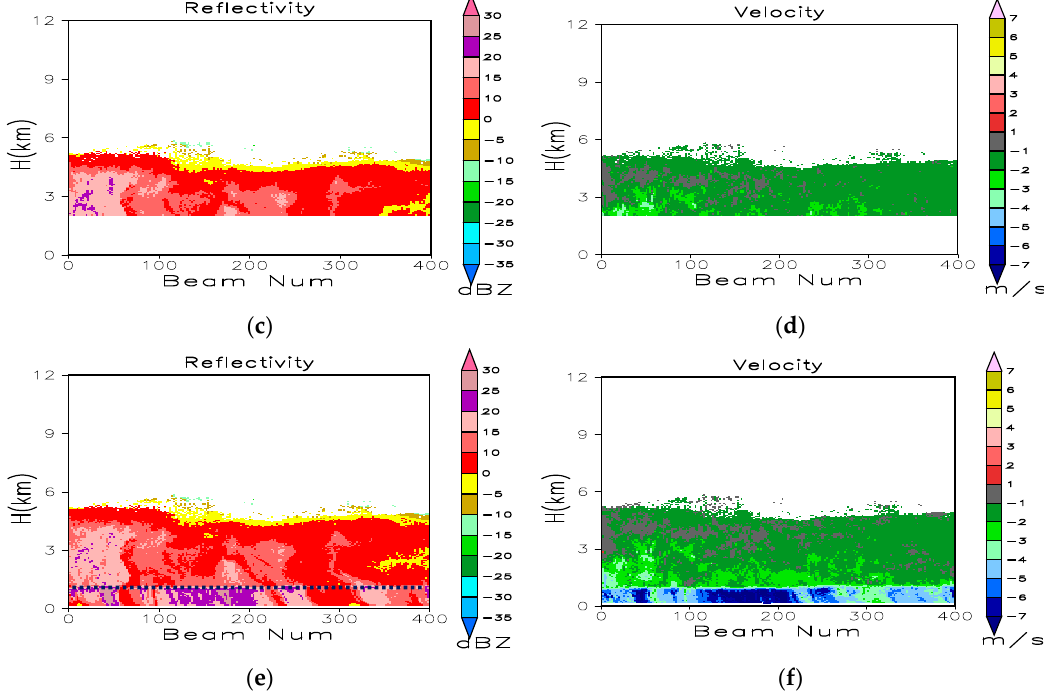
Figure 4. Time–height cross sections of 500 profiles for quality controlled ( a ) reflectivity and ( b ) velocity